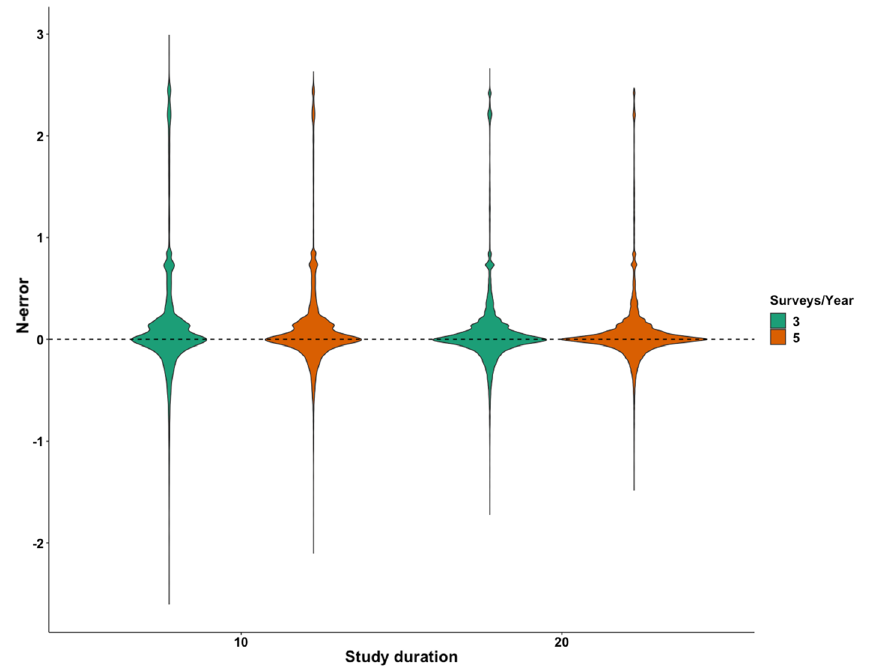
Figure 3. Violin plots of the observed error in abundance estimation (N-error) for different levels of study duration (10 and 20 years) and survey effort (3 and 5 surveys per